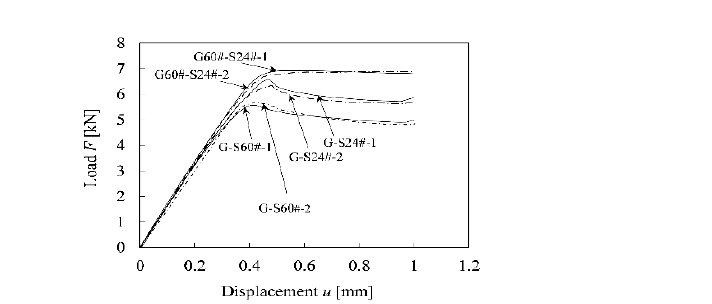
Figure 7. The load–displacement curves of specimens with different grit-blasting surface treatments.